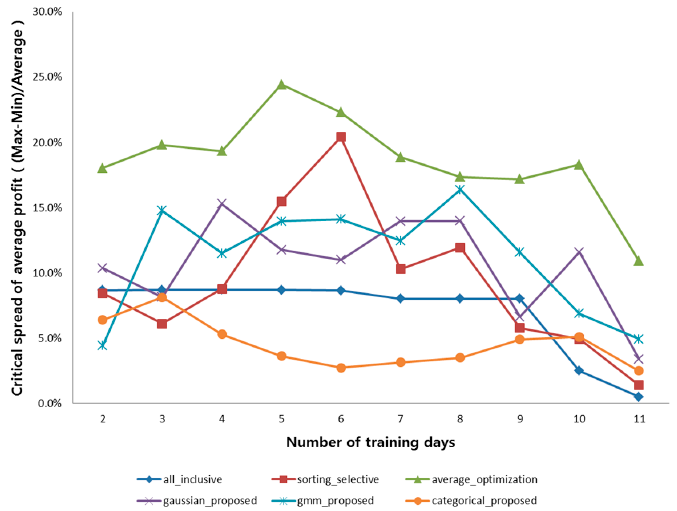
Figure 10. Comparison of critical spread of average profit. The proposed method with categorical distribution provides very low error, and very high stability.